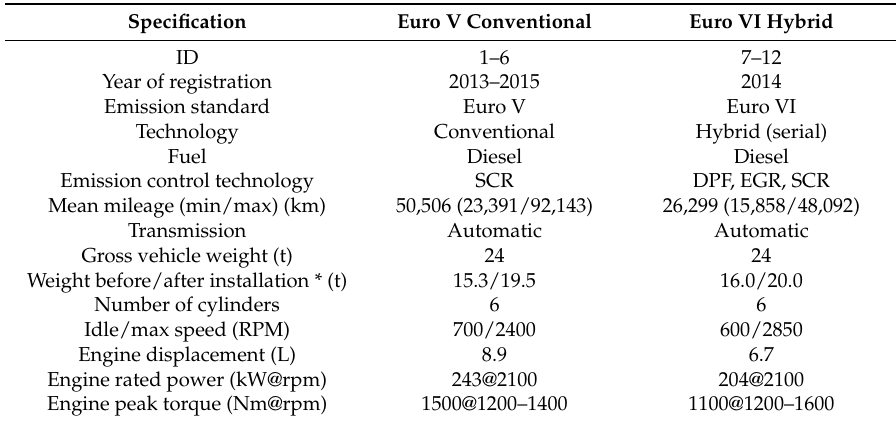
Table 1. Overview of diesel and hybrid-diesel bus